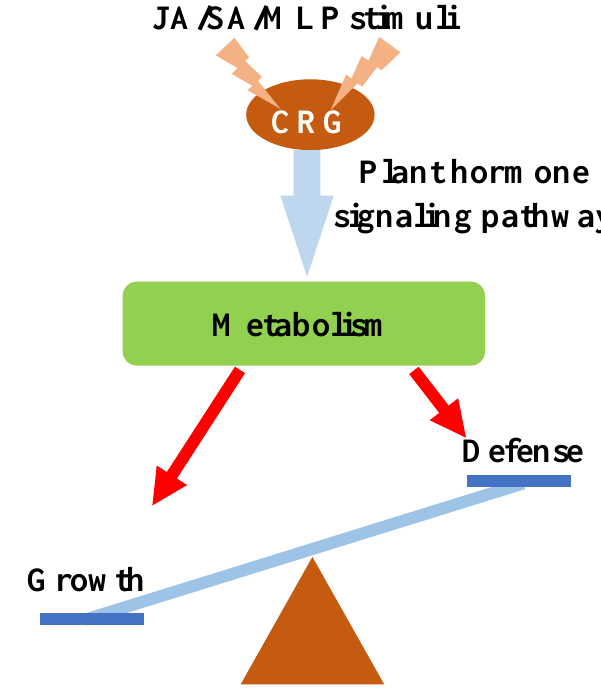
Figure 9. Schematic model representing the possible roles of common responsive genes (CRG) in regulating plant defense.